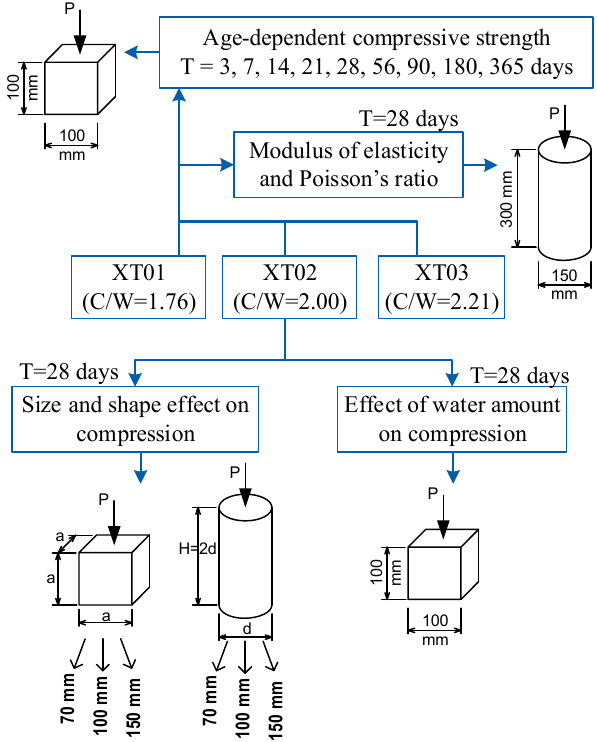
Figure 1. Layout of testing program.